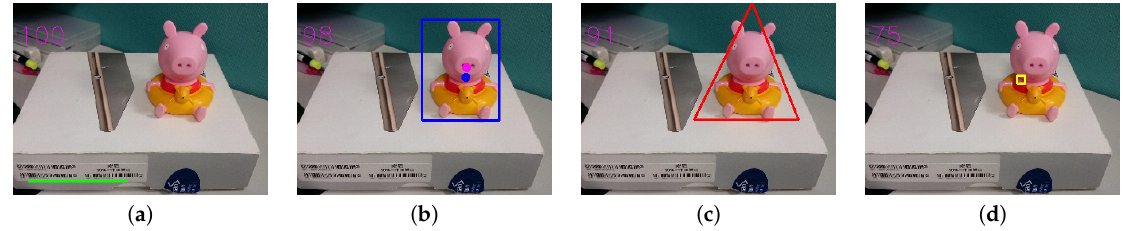
Figure 28. ( a ) Horizontal composition. ( b ) Rule of thirds composition. ( c ) Triangle composition. ( d ) Focus composition.